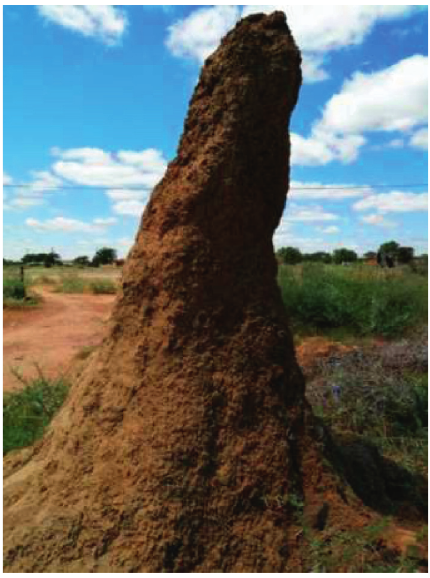
Figure 1: A Macrotermes mound in Palapye, Central Botswana (photo: Peter N.